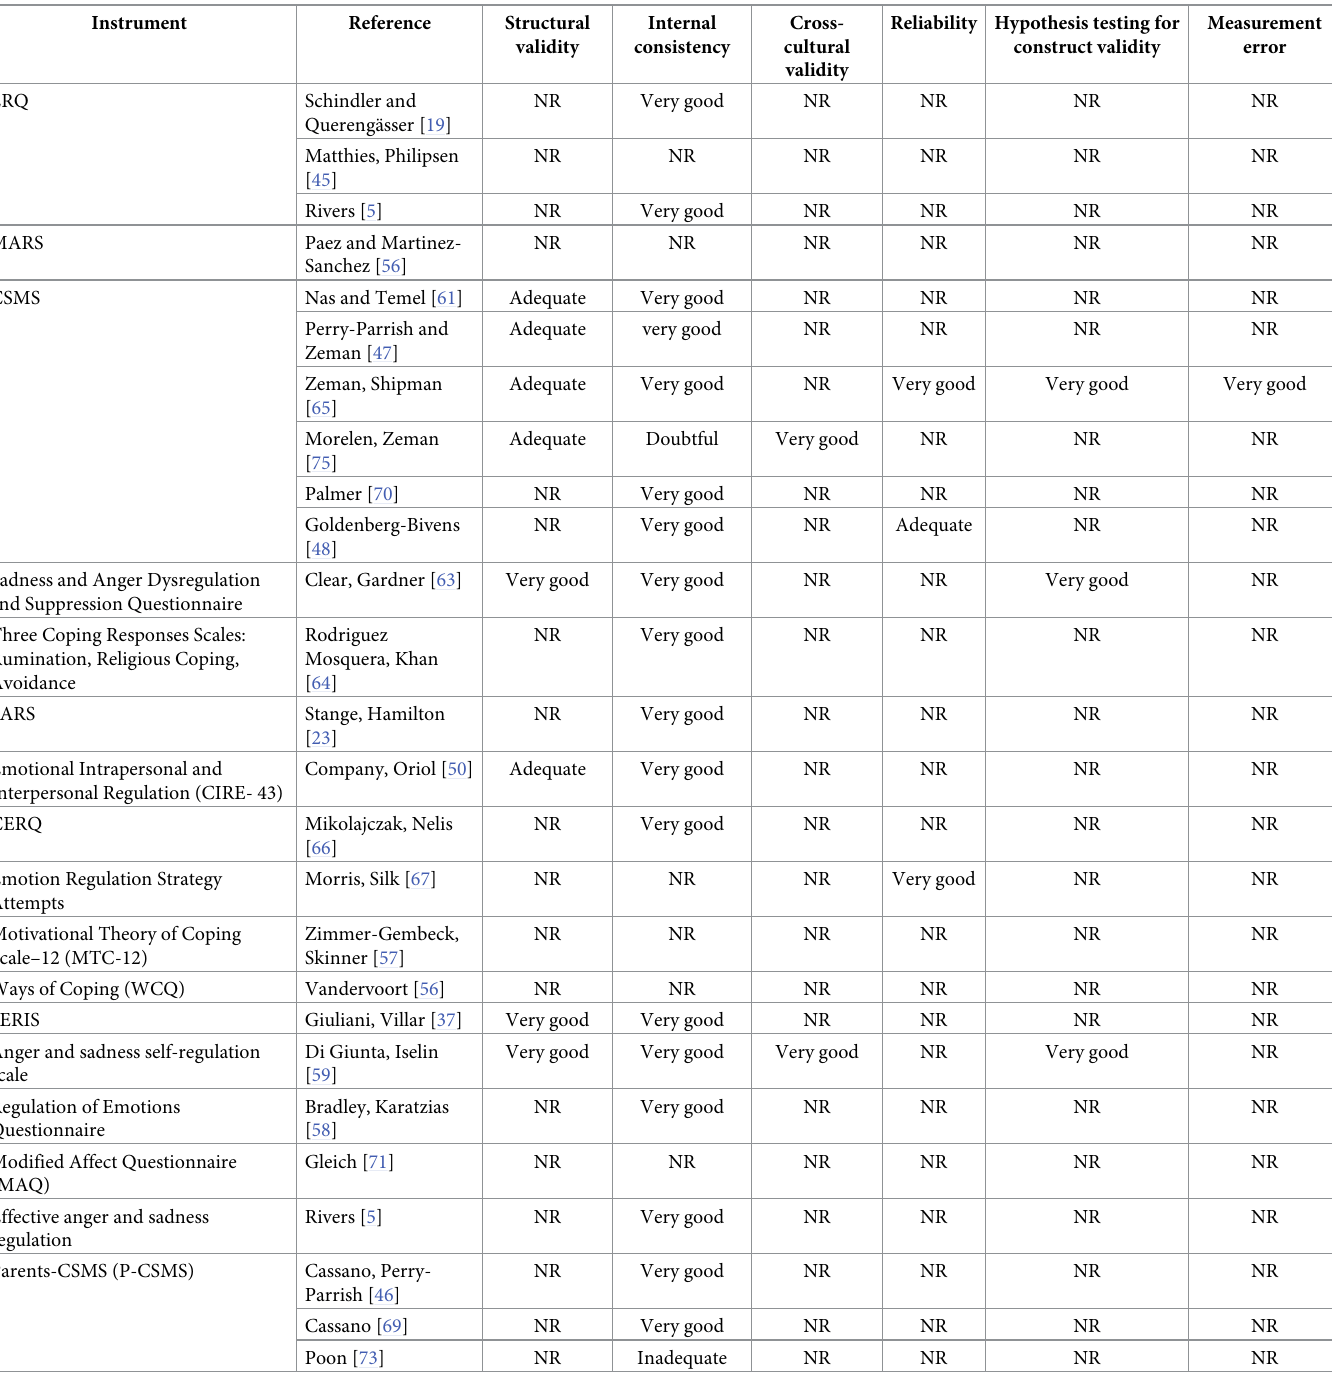
Table 3. Methodological quality assessment of studies on psychometric properties of the included